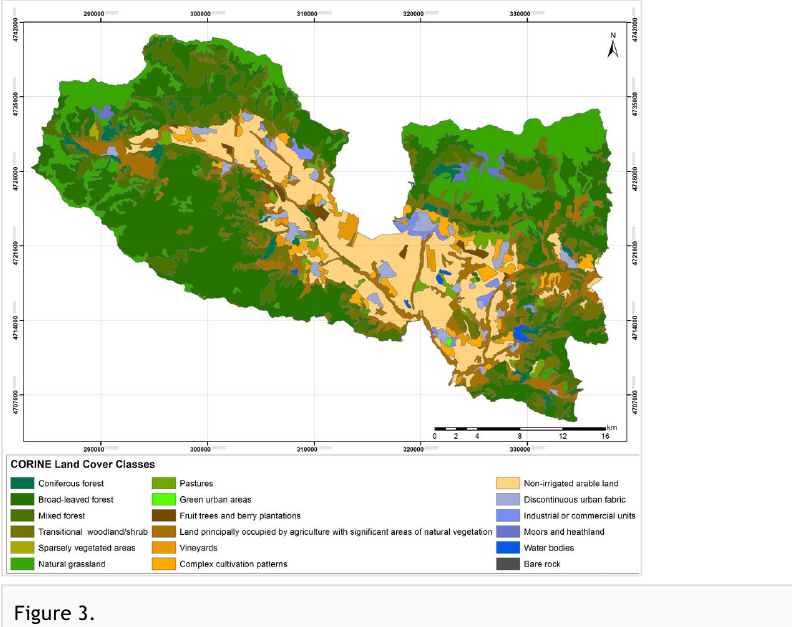
Ecosystem Sub-classes at Karlovo Municipality, Represented by Respective CLC